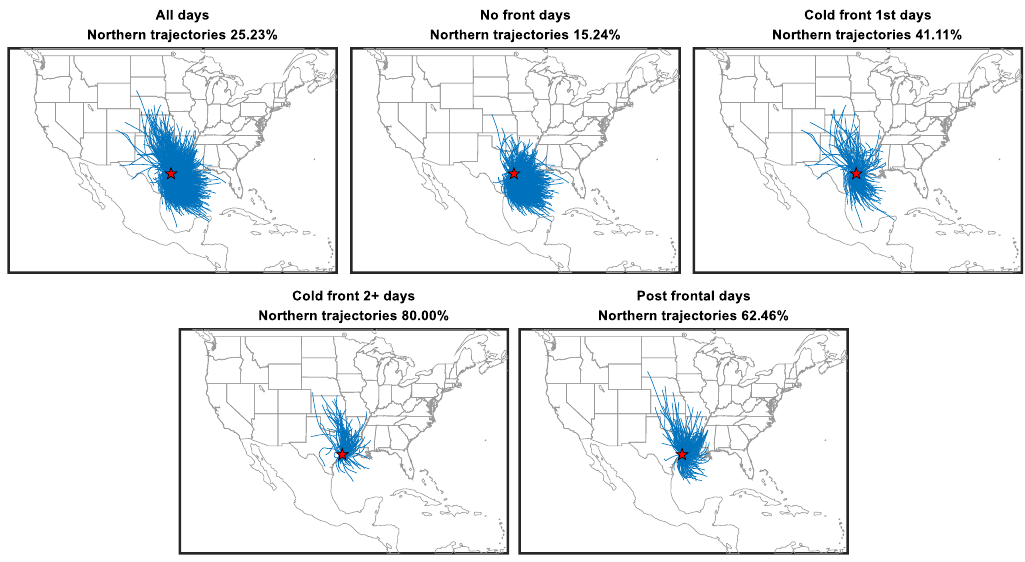
Figure 4. Twenty-four-hour back trajectories starting at 15:00 CST during ( a ) all days; ( b ) no front days; ( c ) cold front 1st days; ( d ) cold front 2+ days; and ( e ) post frontal